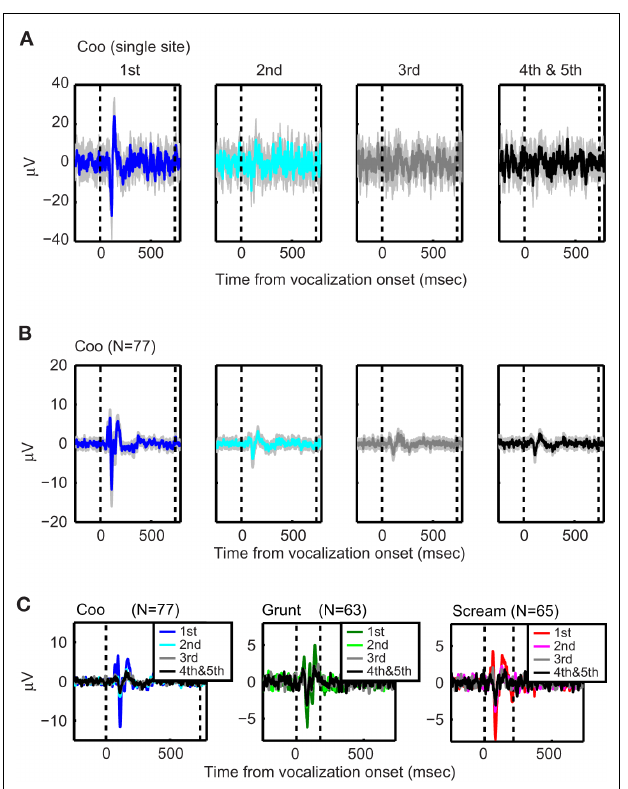
FIGURE 2 |The stimulus-evoked LFP decreased with repeated presentations of a stimulus. The data in (A) show an example from a single site (1st–3rd: n = 25 trials, 4th and 5th: n = 22 trials); whereas those in (B,C) show population-level stimulus-evoked LFP. In (A,B) , the data illustrate the effect that repeated presentations of the coo vocalization had on the LFP.The data in the first column illustrate the LFPs from the first vocalization presentation.The data in the rightmost column illustrates the LFPs from the fourth and fifth vocalization presentations; the data from fourth and fifth presentations were combined.The gray error bars are bootstrapped 95% confidence intervals of mean.The data in (C) illustrate how the stimulus-evoked LFP decreased as a function of stimulus presentation.The data in each column were generated with a different vocalization: coo (left; n = 77 sites), grunt (middle; n = 63 sites), and scream (right; n = 65 sites).Within each plot, the stimulus-evoked LFP are plotted as a function of stimulus presentation. All of the data are aligned relative to vocalization onset (i.e., the vertical dotted line at time t = 0).The second dotted line indicates vocalization